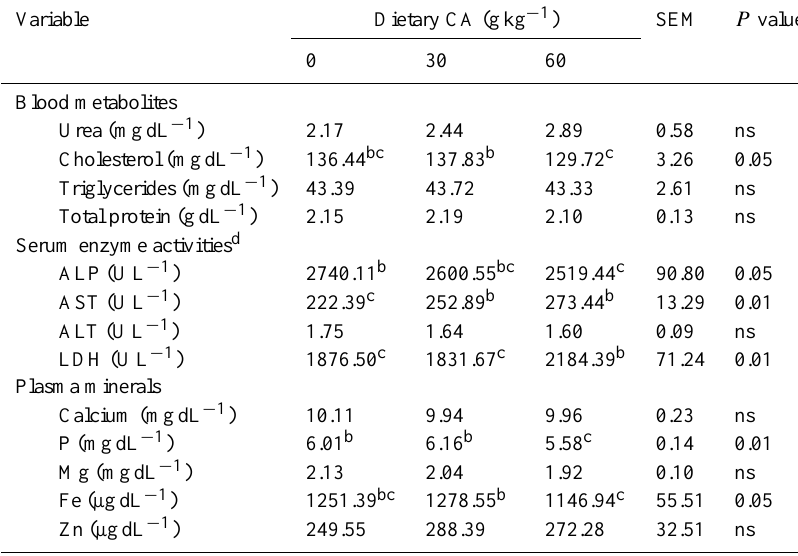
Table 4. Effect of citric acid on select blood parameters and serum enzyme activities a